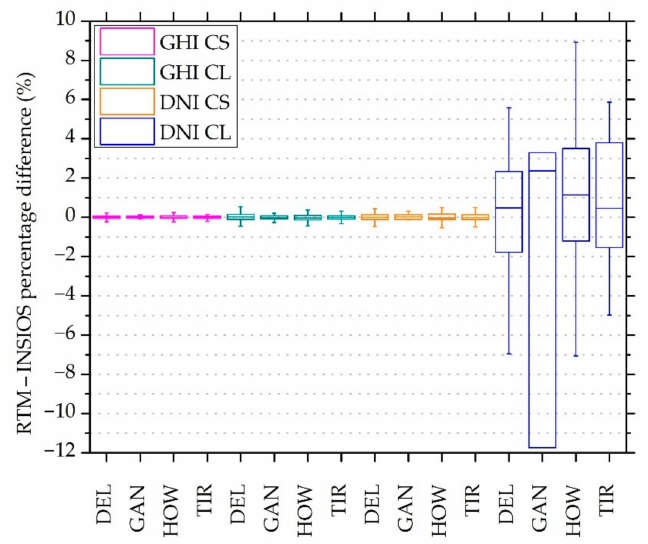
Figure 4. Percentage di ff erence of GHI and DNI estimated from INSIOS technique as compared to RTM simulations for clear and cloudy conditions for all stations. RTM: radiative transfer model, CS: clear-sky, CL: